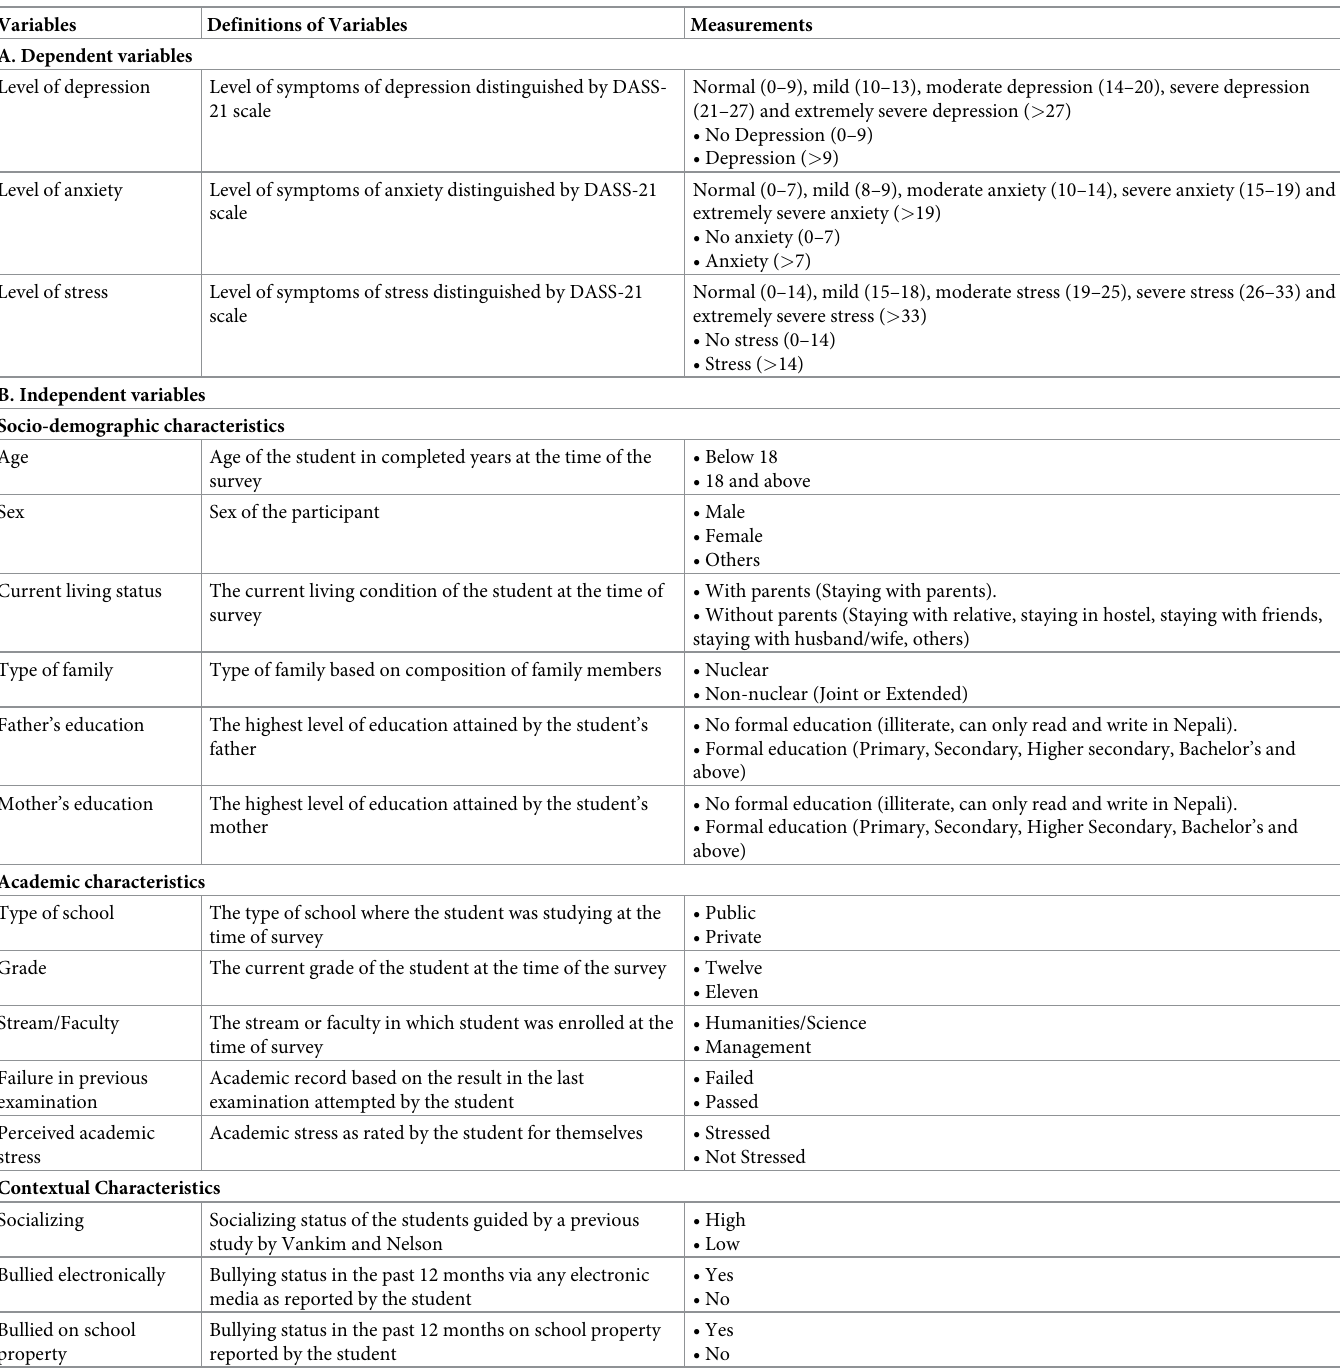
Table 1. Summary of study